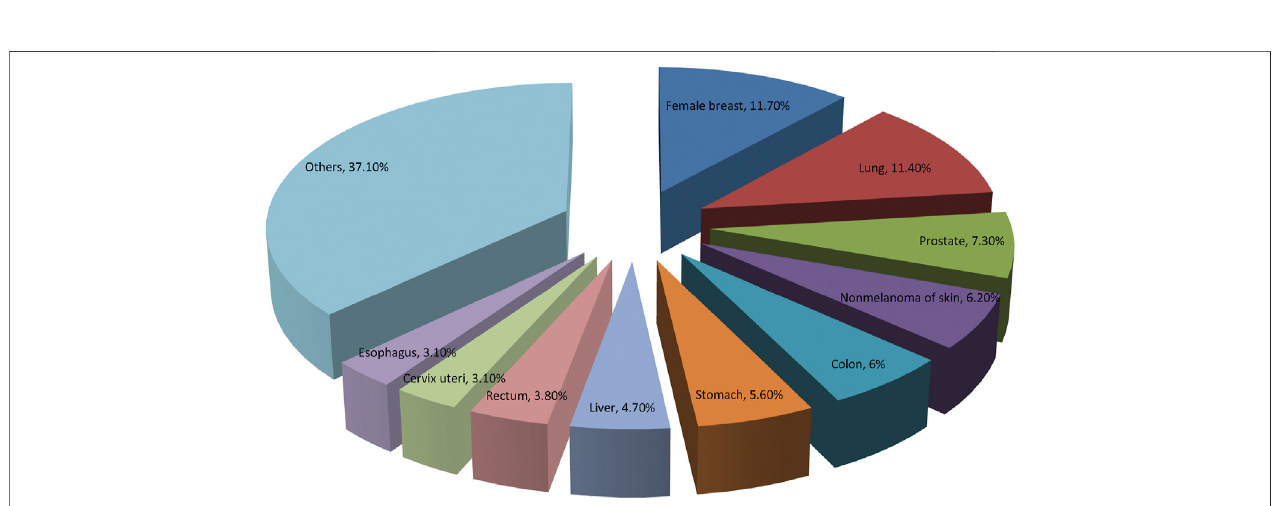
FIGURE 2 | The prevalence of the top 10 most common cancers according to the GLOBOCAN 2020. Breast cancer has replaced lung cancer as the most common cancer worldwide.